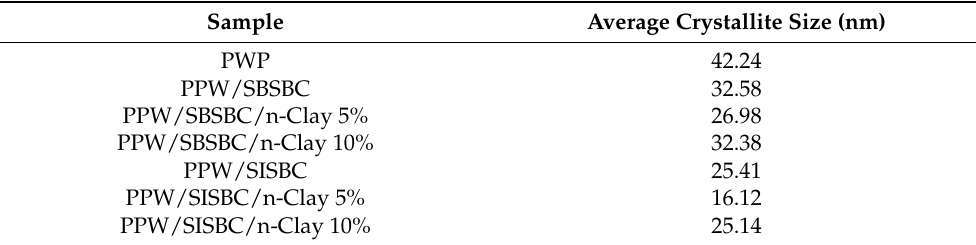
Table 5. The average crystallite size of PPW composites.